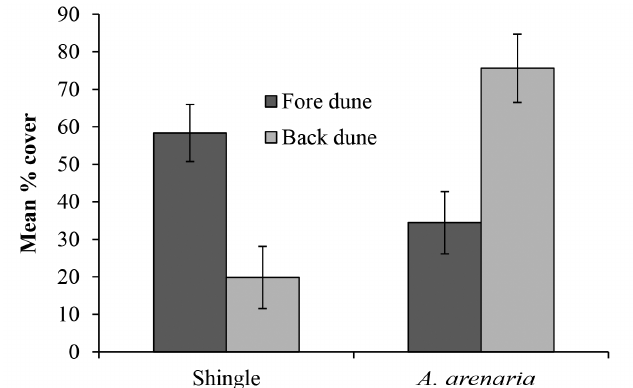
Fig. 5. Mean ground cover of shingle and Ammophila arenaria on the fore and back dunes post-surge. back dunes pre-surge (t = 0.79). However, post-surge, stridulating males were much more frequent on the back than the fore dunes (t = 3.19, p = 0.04) (Fig. 4). The mean cover of A. arenaria on the fore dunes was signifi- cantly lower (t = -2.62, df, p = 0.01) than on the back dunes in total contrast to the cover of shingle which was higher (t = 4.23, p<0.0001) on the fore dunes post-surge (Fig.